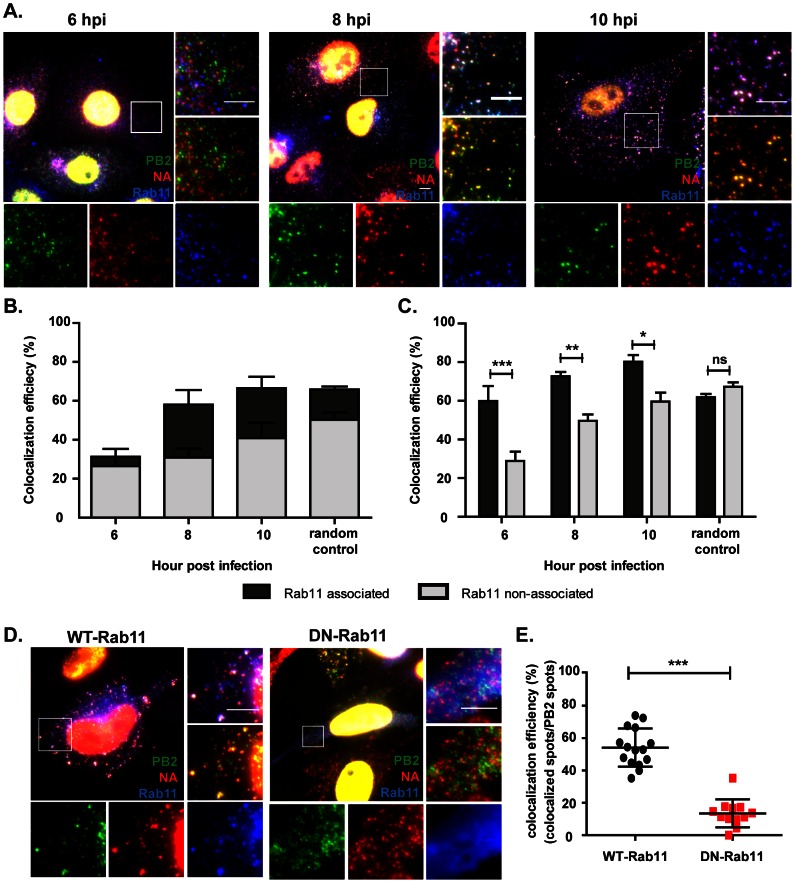
Rab11 is involved in the colocalization of PB2 and NA vRNAs.(A–C) A549 cells are infected with PR8 virus at MOI = 5 and were fixed at 6, 8 and 10 hpi. Immunofluorescence staining was performed using anti-Rab11 antibody followed by two-color smFISH using Cy5-labeled PB2 probes and Cy3-labeled NA probes. (A) Merged fluorescent images of cells at 6, 8 and 10 hpi are shown on the upper left corners (Maximum Intensity Projection). For each panel, the boxed region is enlarged and shown on the upper right corner. The enlarged images of the PB2 vRNAs (green), NA vRNAs (red), and Rab11 (blue) are shown at the bottom, and the merged image of the PB2 and NA vRNA signals is shown on the middle right. Scale bar = 5 µm. (B) Colocalization efficiency of the PB2 and NA vRNA in the cytoplasm at 6, 8 and 10 hpi. The colocalized vRNAs that colocalize with Rab11 are represented in dark gray while the colocalized vRNAs that are not associated with Rab11 are shown in light gray. The percentages of colocalized vRNAs associated with Rab11 are 31.3% at 6hpi, 44.9% at 8hpi, 38.8% at 10hpi and 24% for random control. Error bars represent standard deviation. (C) Colocalization efficiency of PB2 and NA vRNAs associated with and not associated with Rab11 in cells at 6, 8 and 10 hpi. The random control represents the colocalization efficiency of PB2 and NA vRNA when the vRNAs were randomly classified into Rab11-associated and Rab11-non-associated groups. Error bars denote standard deviations. ***: t-test p value<0.001, **: t-test p-value<0.01 and *: t-test p value<0.05. (D&E) A549 cells were transfected with 1 µg of GFP-rab11-WT or GFP-rab11-DN and infected with PR8 virus at MOI = 5 at 24 hour post transfection. Two-color smFISH using Cy5 probes targeting the PB2 vRNAs and Cy3 probes targeting the NA vRNAs were performed at 8 hpi. (D) Images are shown for cells transfected with WT-Rab11 or DN-Rab11 (Maximum Intensity Projections). Magnified images of the boxed areas are shown: the separate images showing PB2 vRNAs (green), NA vRNAs (red) and GFP-tagged rab11 proteins (blue) are at the bottom; a merged image of the PB2 and NA vRNAs is shown at the middle right while the merged image of the three channels is located on the upper right corner of the panel. Scale bar = 5 µm. (E) Colocalization of PB2 and NA vRNAs in WT-Rab11 or DN-Rab11 expressing cells. The colocalization efficiency of PB2 and NA vRNAs were analyzed for individual cells that were detected with GFP signal (expressing the GFP-tagged rab11 proteins). The black dots symbolize the colocalization efficiency of vRNAs in WT-Rab11 transfected cells while the red squares symbolize the colocalization efficiency in DN-Rab11 transfected cells. The error bars represent standard deviations. ***: t-test p value<0.001.